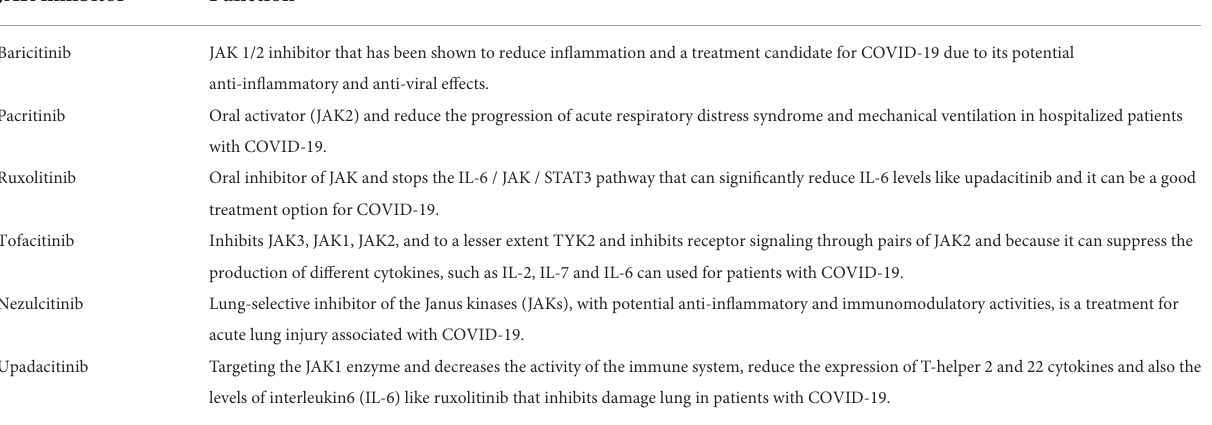
TABLE 1 Summary of IL-6/JAK/STAT3 inhibitors in